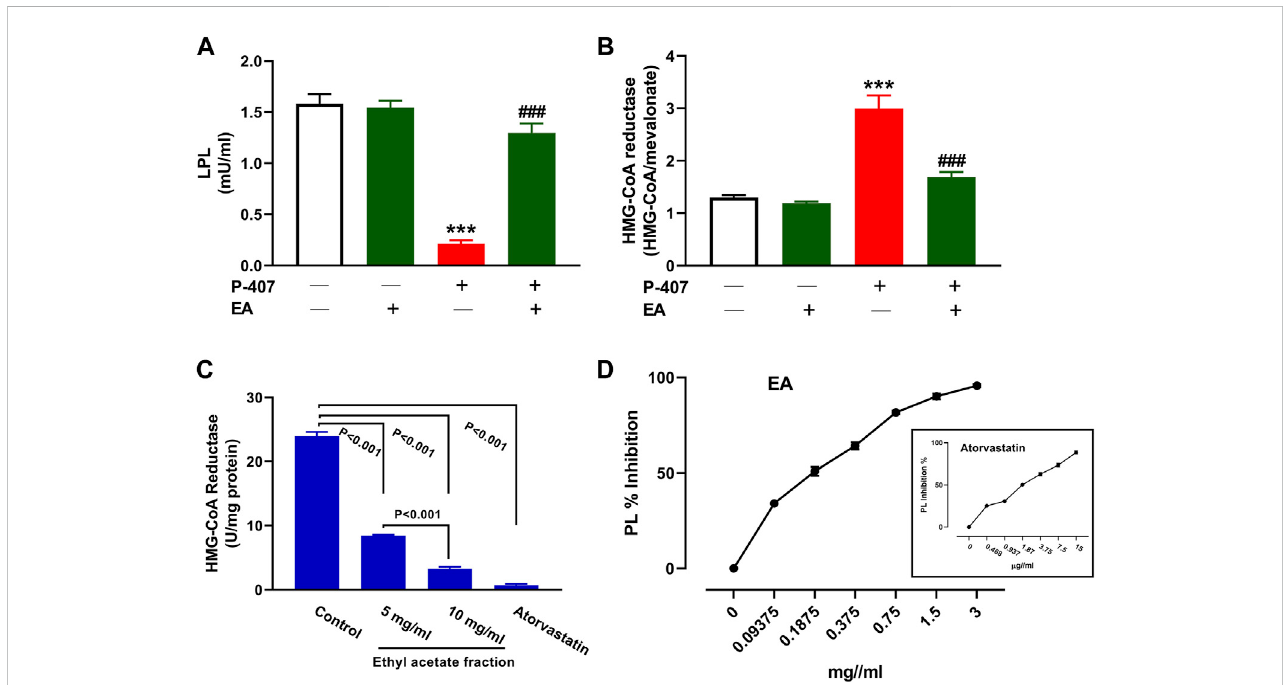
FIGURE 11 Effect of theEA fraction on plasma LPL (A) and hepatic HMG-CoA reductase (B) in P-407-administeredrats. Values are represented as mean ± SEM, ( n = 6). *** p < 0.001 versus Control and ### p < 0.001 versus P-407. (C – D) Inhibitory activity of EA fraction on HMG-CoA reductase (C) and pancreatic lipase (D) in vitro . Data are Mean ± SEM ( n =